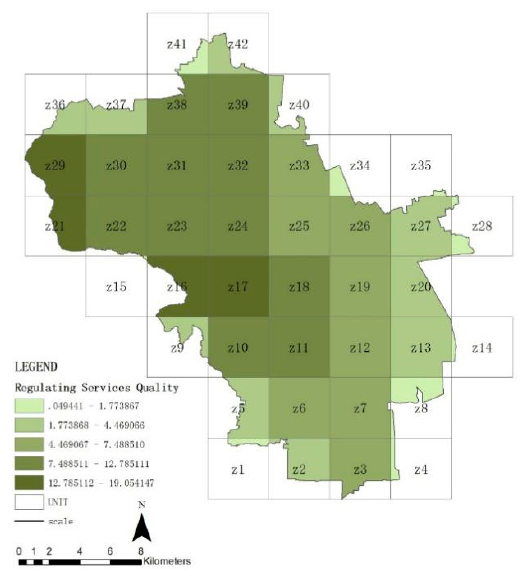
Figure 8. Quality distribution of regulating service of units.